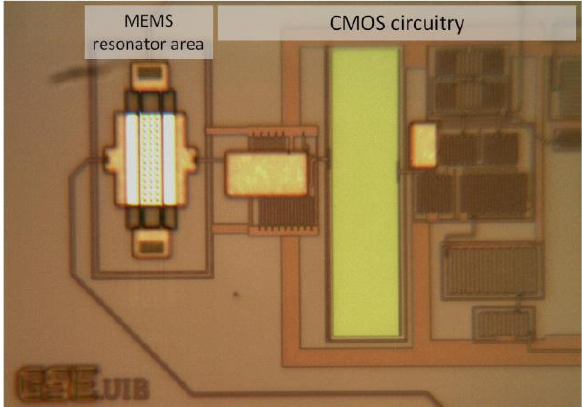
Figure 2. Optical image of the MEMS resonator integrated together with the CMOS amplifier using a monolithic solution. Both the resonator and CMOS circuitry are fabricated in a 0.35- μ m commercial technology.